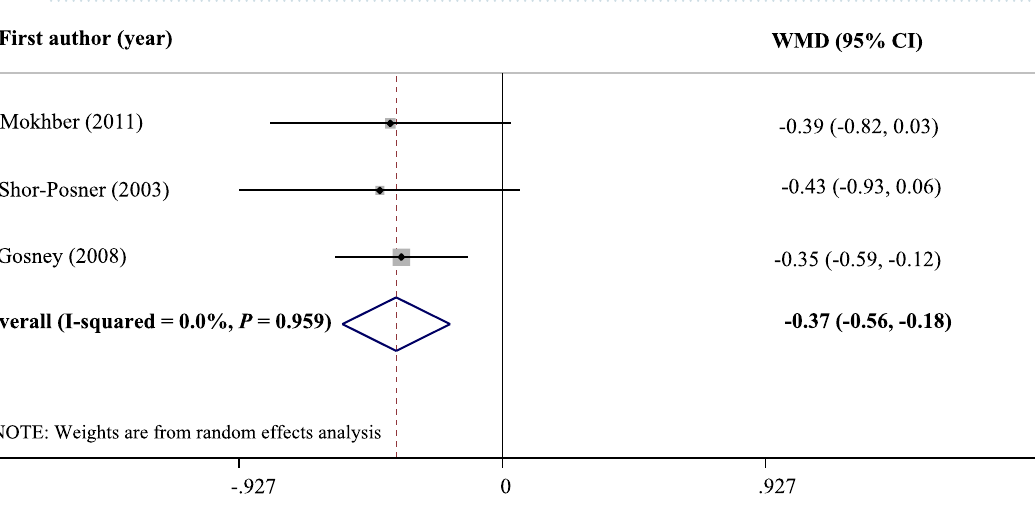
Figure 5. Forest plot of the effect of selenium supplementation on depression